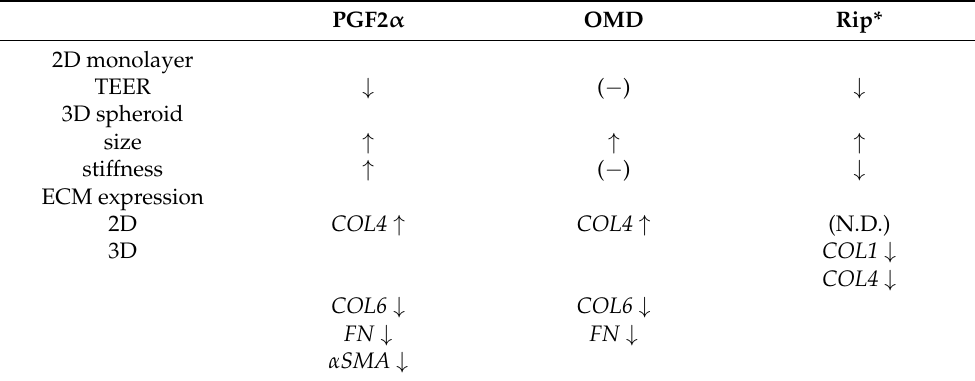
Table 2. Comparison of the drug-induced effects on the TEER values of the 2D HTM monolayers, and physical properties, size and stiffness, and mRNA expression of ECM molecules with 3D HTM spheroids. PGF2 α OMD